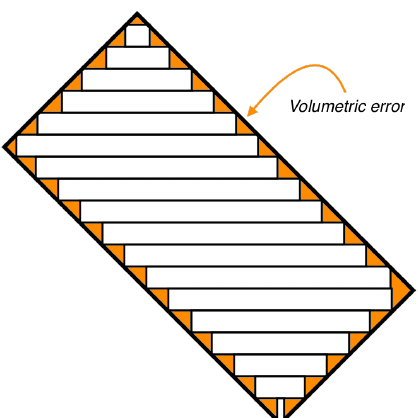
Figure 4. Graphical visualization of volumetric error.